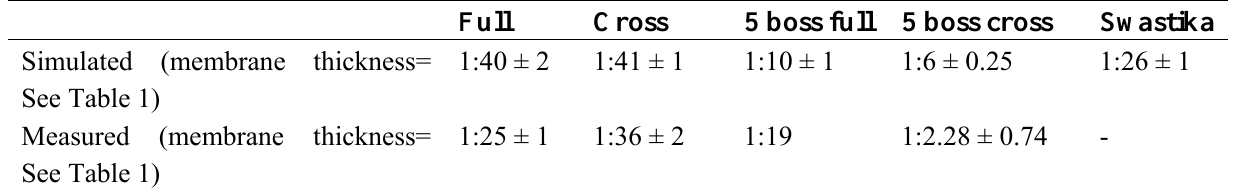
Table 2. Simulated and measured horizontal to vertical stiffness ratio. Full Cross 5 boss cross